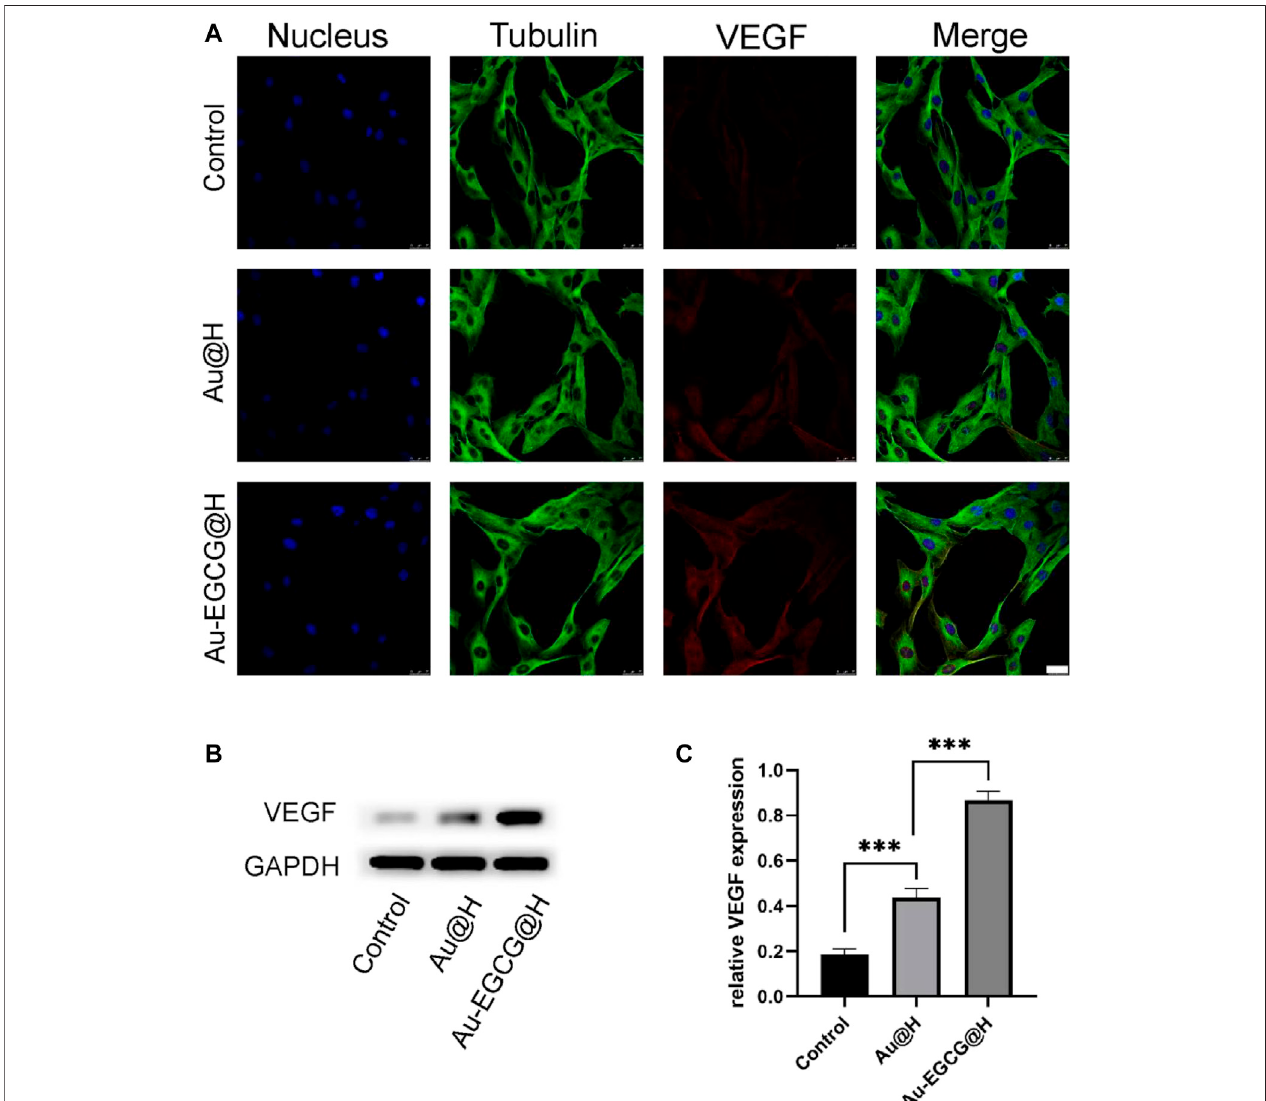
FIGURE4| Theexpressionanalysisofvascularendothelialgrowthfactor(VEGF)underdifferenttreatments. (A) Theimagesofconfocallaserscanningmicroscopy (CLSM) for the VEGF expression analysis, bar (cid:2) 25 μ m. (B) The VEGF protein expression level was explored through western blot. (C) Quanti fi cation analysis of the VEGF protein. * p < 0.05, ** p < 0.01, *** p < 0.001.